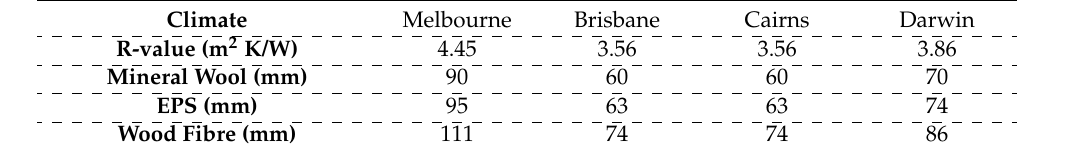
Table 6. Wall R-value (given by WUFI) of the Passivhaus pilot projects in the selected loca-tions, exclusive of 2D and thermal bridging effects. The insulation thickness for each location is also